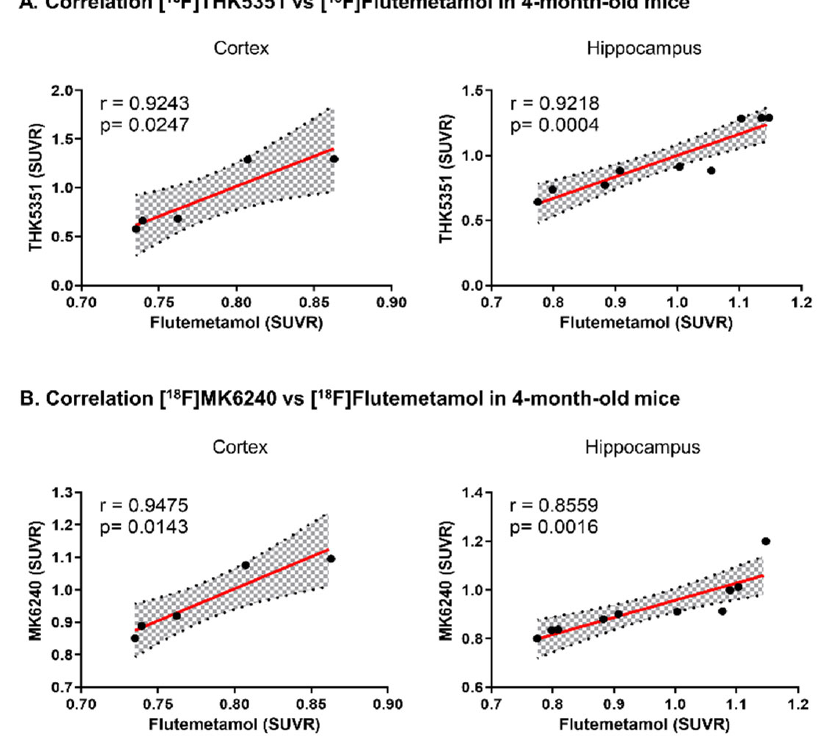
Figure 6. Correlation between [ 18 F]THK5351 or [ 18 F]MK6240 uptake and [ 18 F]Flutemetamol uptake in brain. ( A ) The correlation between [ 18 F]THK5351 uptake and [ 18 F]Flutemetamol uptake were assessed in the cerebral cortex and hippocampus of 6 × Tg mice by the nonparametric Spearman’s rank correlation test. Graphs show regression lines with 95% confidence intervals. [ 18 F]THK5351 uptake significantly correlates with [ 18 F]Flutemetamol uptake both in the cortex and hippocampus of 6 × Tg mice. ( B ) The correlation between [ 18 F]MK6240 uptake and [ 18 F]Flutemetamol uptake are assessed in the cortex and hippocampus of 6 × Tg mice by the nonparametric Spearman’s rank correlation test. Graphs show regression lines with 95% confidence intervals. [ 18 F]MK6240 uptake significantly correlates with [ 18 F]Flutemetamol uptake both in the cortex and hippocampus of 6xFAD mice.